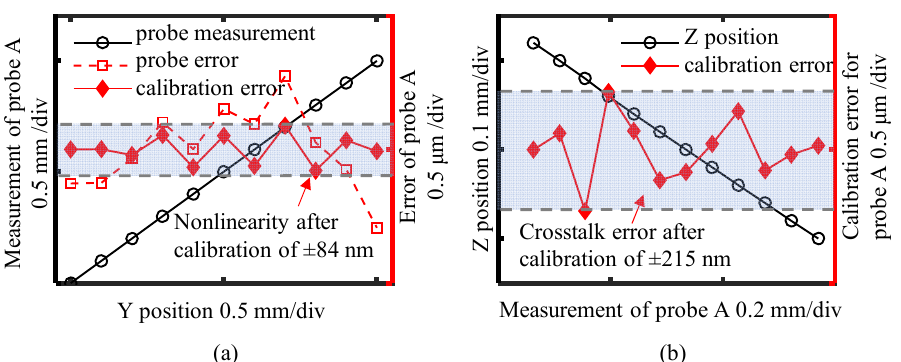
Figure 11. Schematic of the measurement procedure for inner profile surface of the high aspect ratio aspheric workpiece.